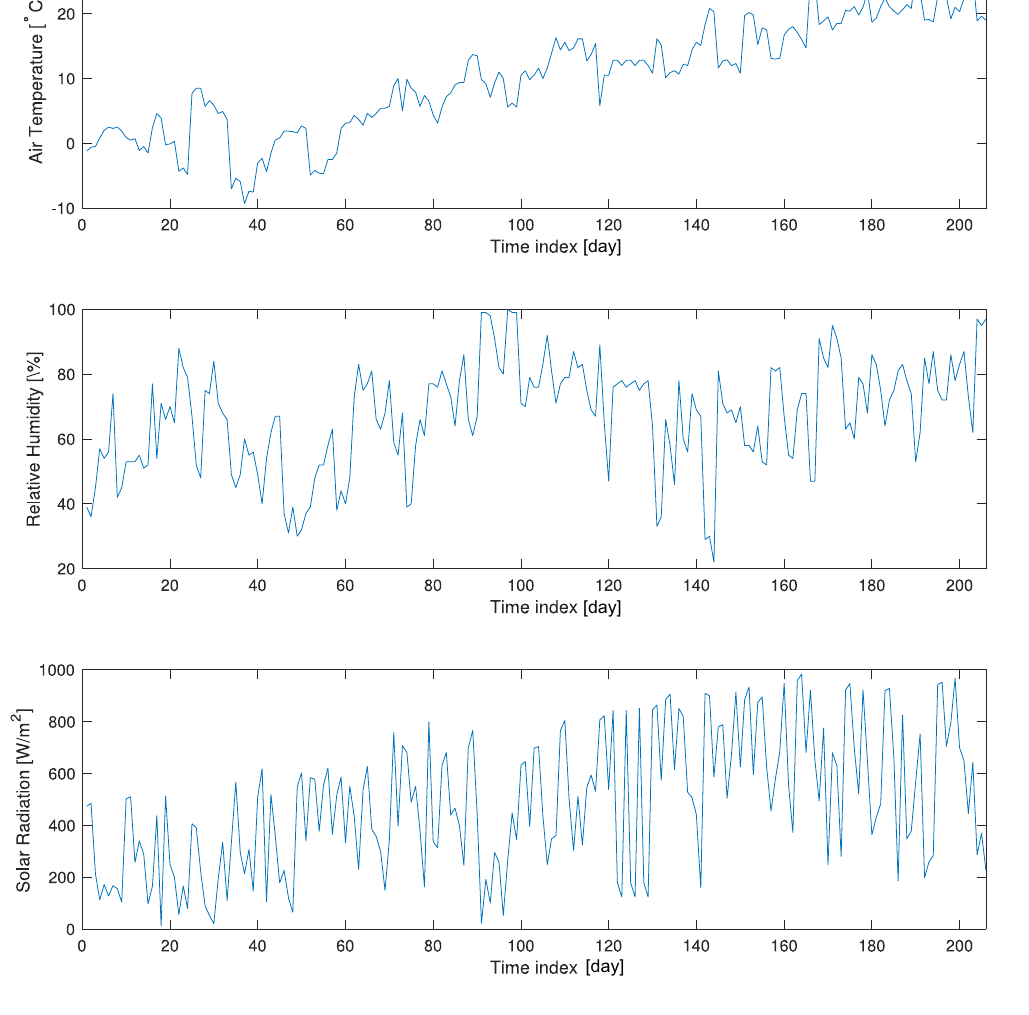
Figure 11. Preparing the spectral brightness temperature and physical temperature pairs for deep